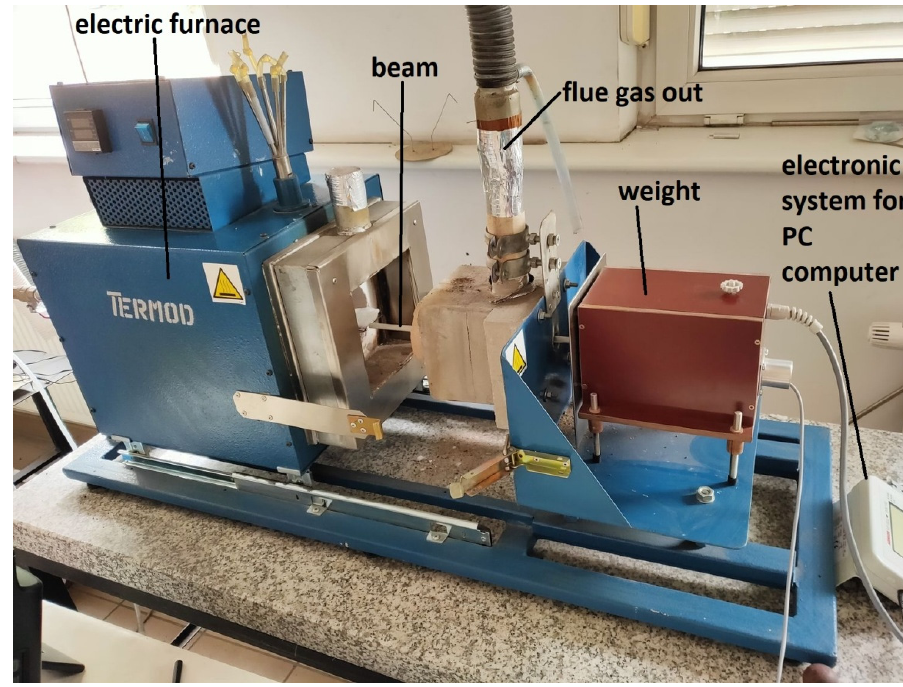
Figure 1. Measuring stand for the sorbent reactivity tests [14,27].